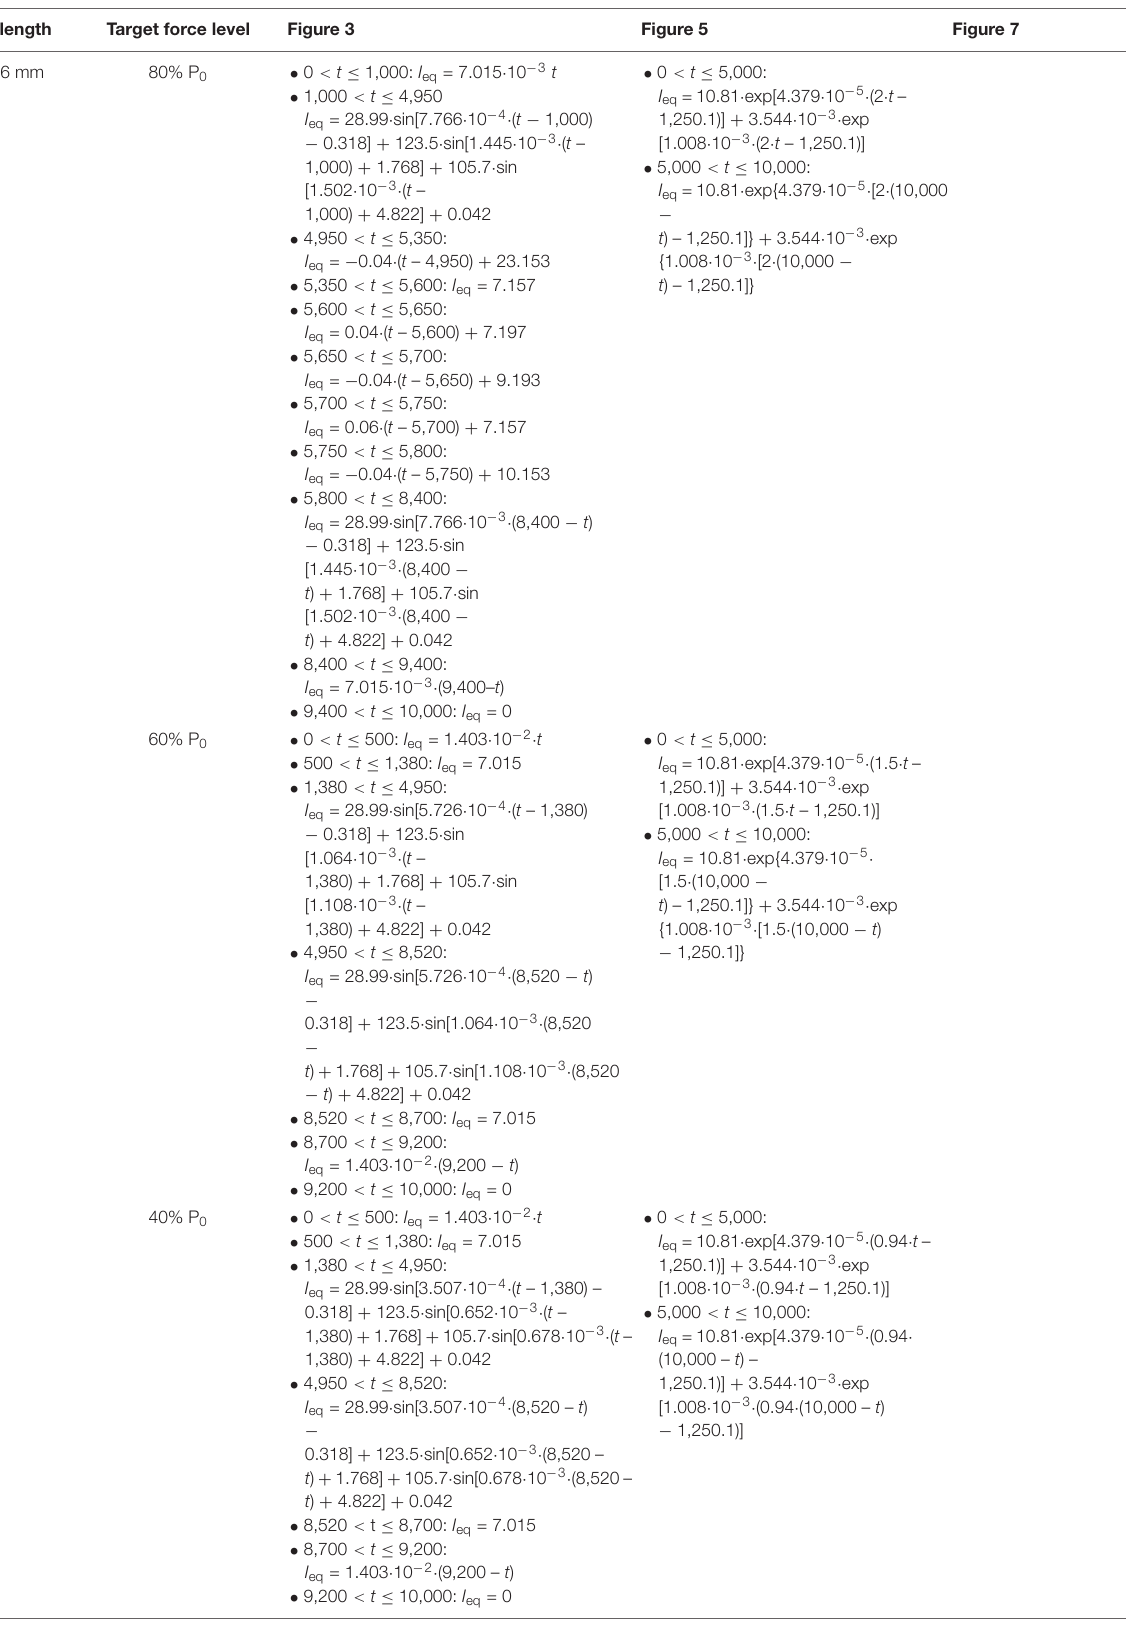
TABLE 1 | Piecewise equations for the time courses of continuous current stimulation (i.e., I eq ) presented in Figures 3 , 5 , 7 . Muscle length Target force